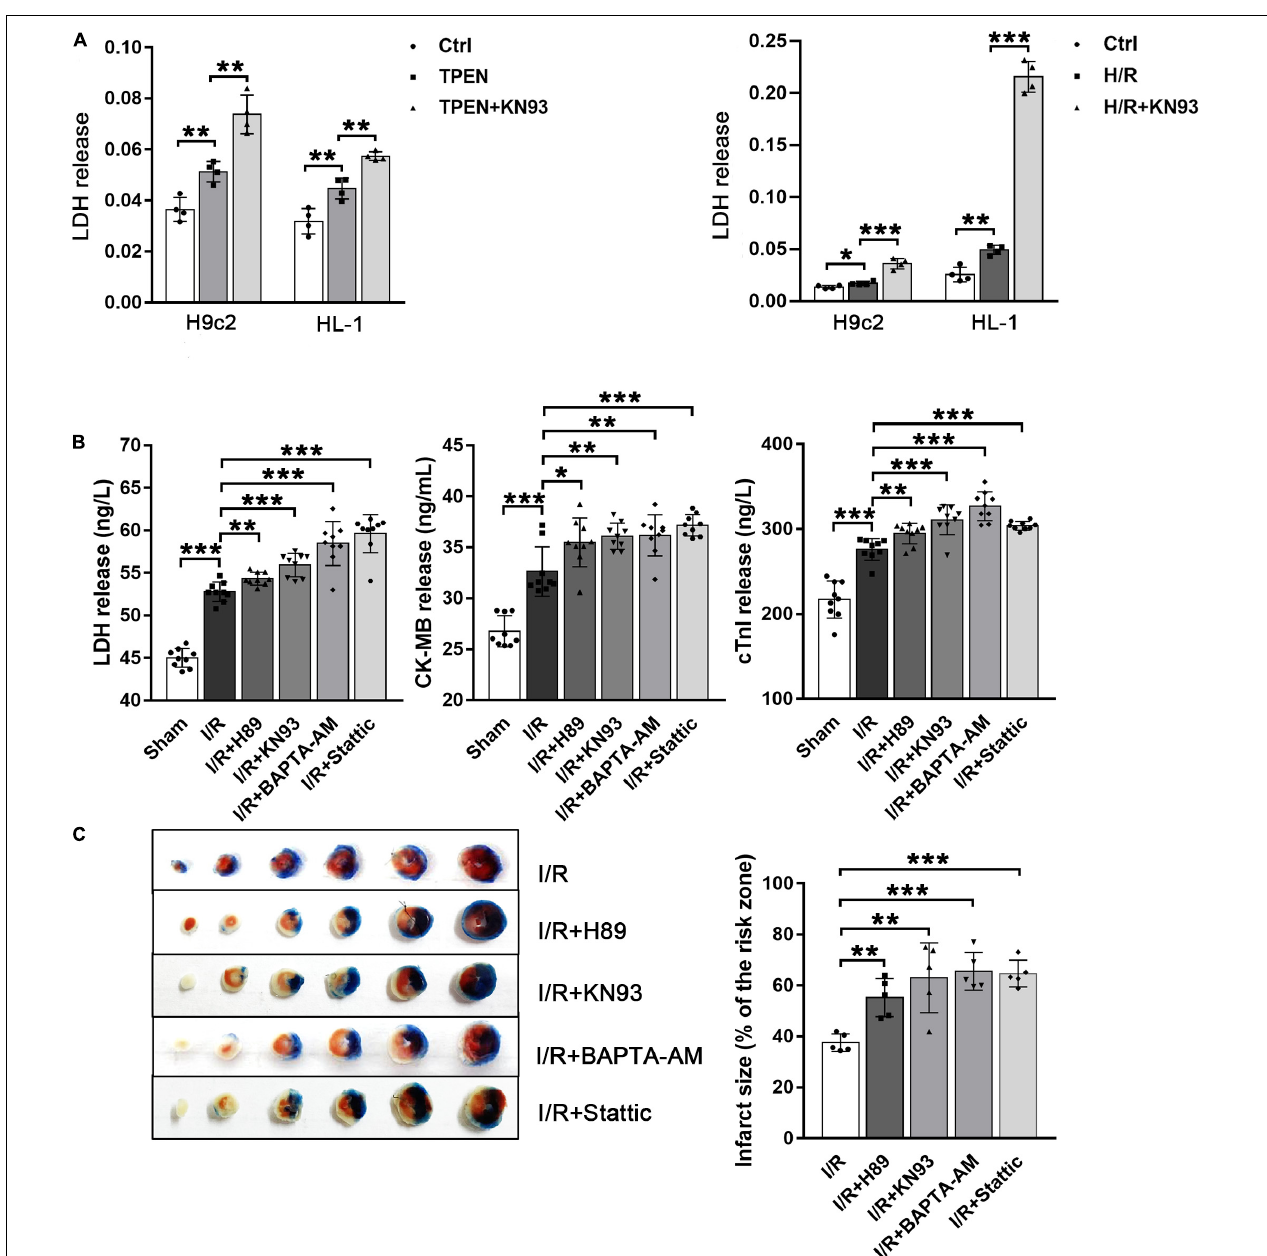
FIGURE 7 | Activated STAT3 can reduce myocardial reperfusion injury. (A) KN93 (10 µ M, n = 4) was applied 2 h before exposure to TPEN for 2 h or 30 min before the onset of reoxygenation. (B) Mouse hearts were ischemic for 30 min and then reperfused for 30 min. After I/R, the release of these myocardial injury markers were detected ( n = 9). (C) Myocardial infarct size was assessed by TTC staining. Mouse hearts were subjected to 30 min ischemia followed by 2 h of reperfusion ( n = 5). * p < 0.05, ** p < 0.01, and *** p <